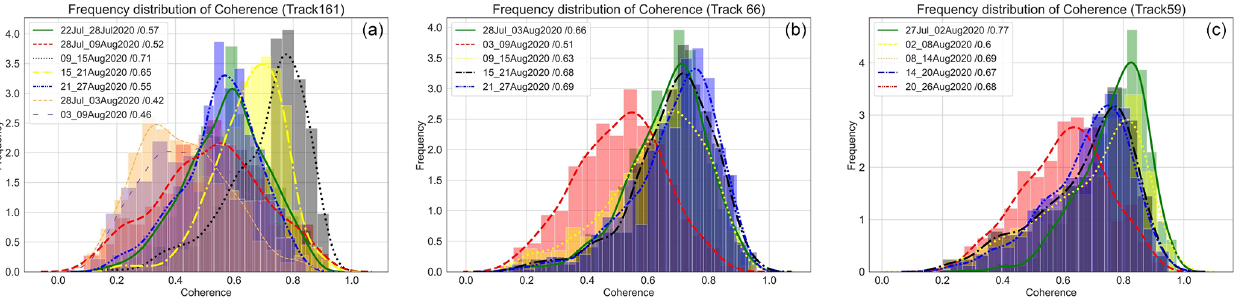
Figure 14. Frequency distributions of coherence values within RoI for all coherence time series